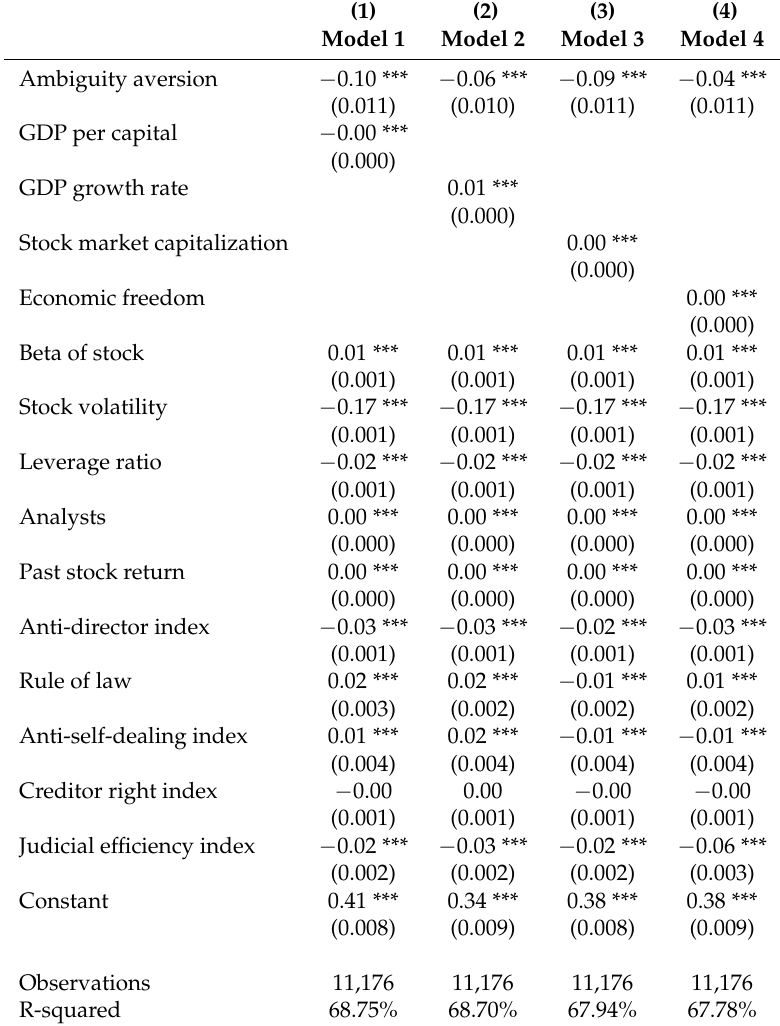
Table 10. Down-weighting outliers for the equity premium and ambiguity aversion.